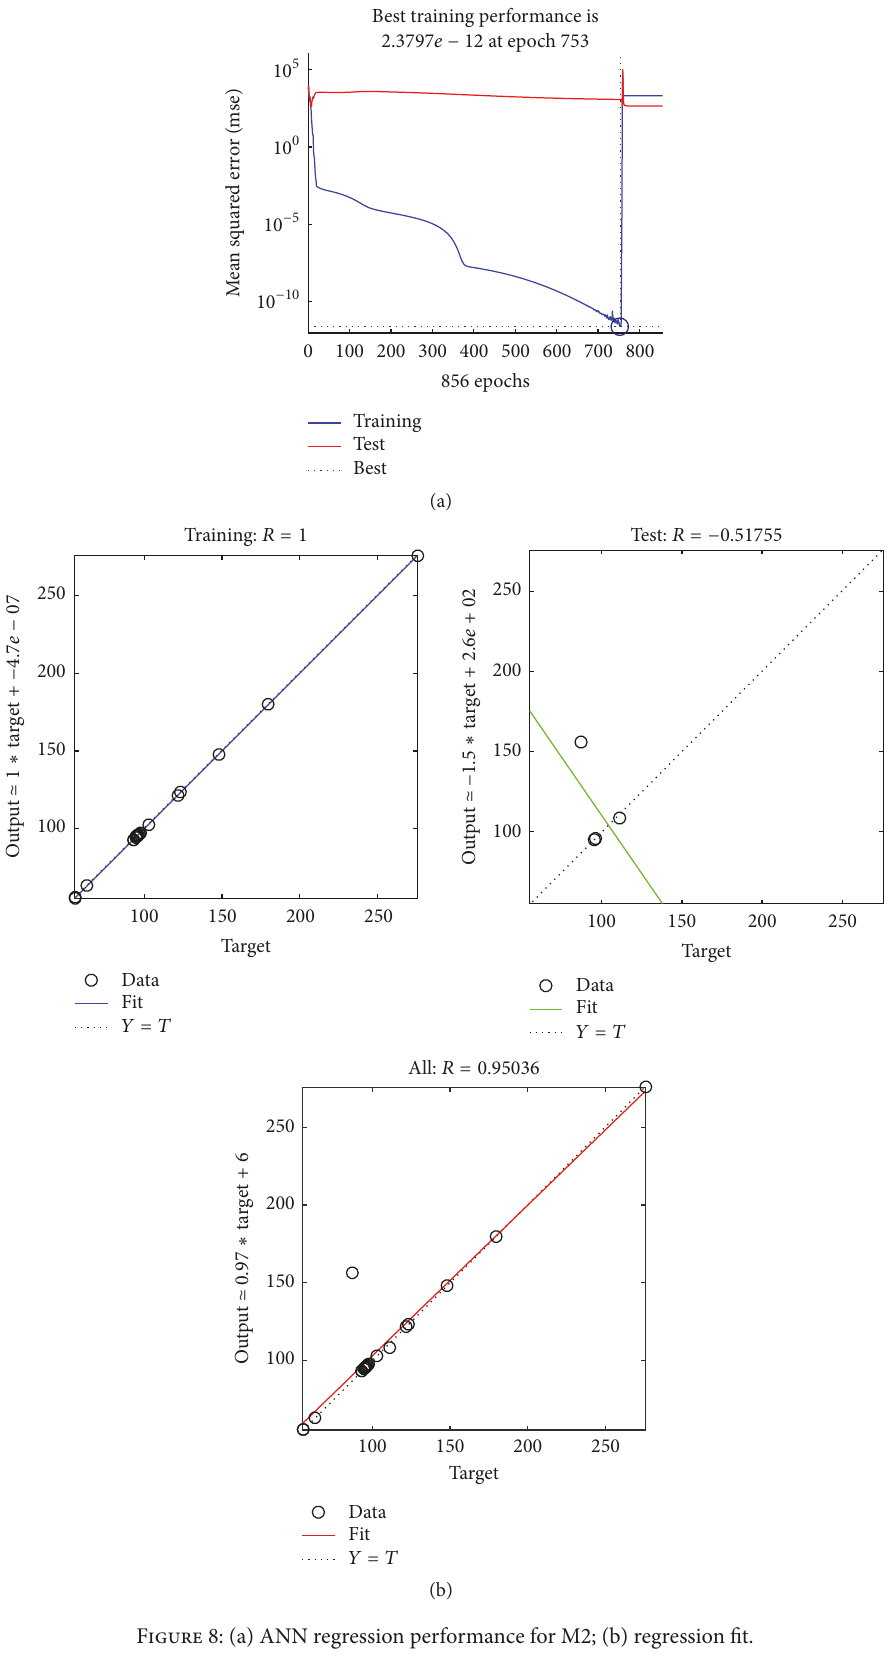
Figure 8: (a) ANN regression performance for M2; (b) regression